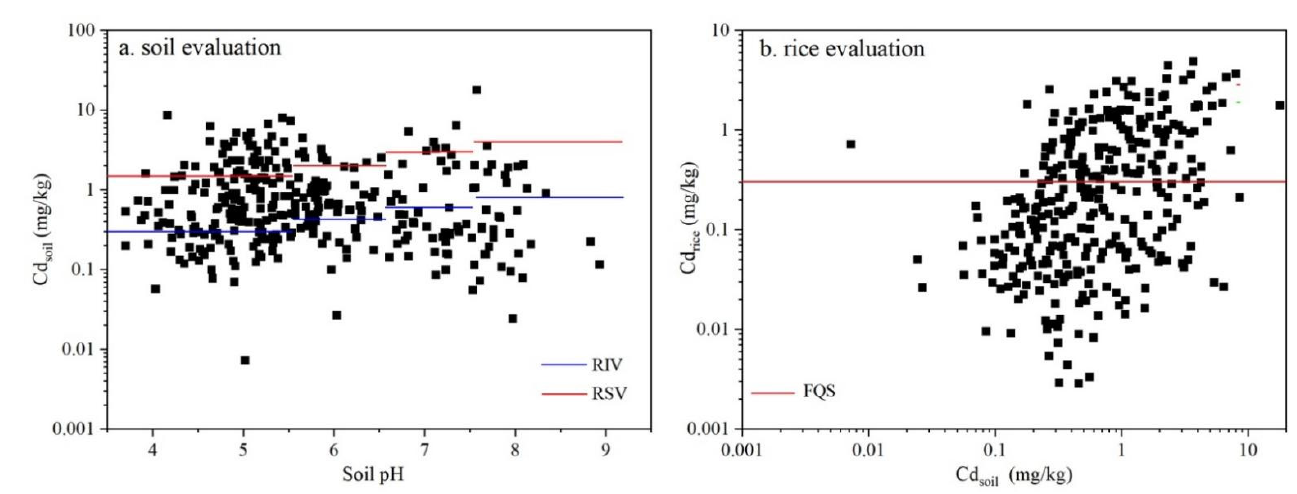
Figure 2. Evaluation of soil–rice grain paired samples based on the Chinese soil and food standards.